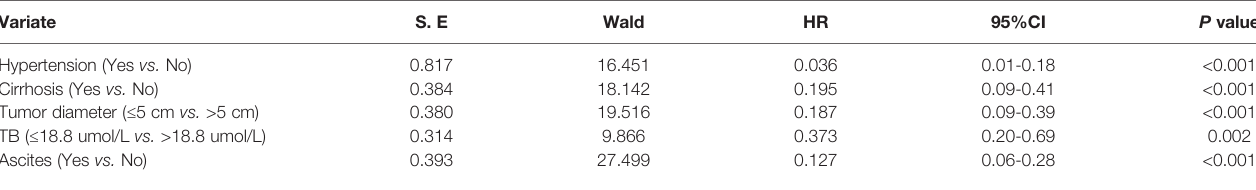
TABLE 2 | Multivariate logistic analysis of predictors of STR in HCC patients (before PSM). Variate S. E Wald